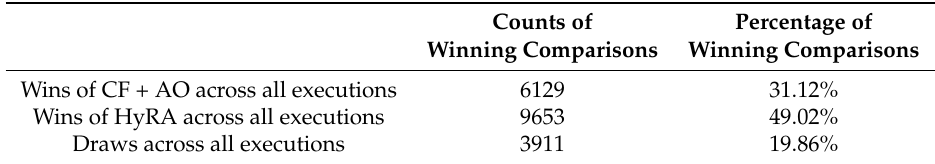
Table 13. Comparison between the user-based CF with an average aggregation operator and HyRA. Counts